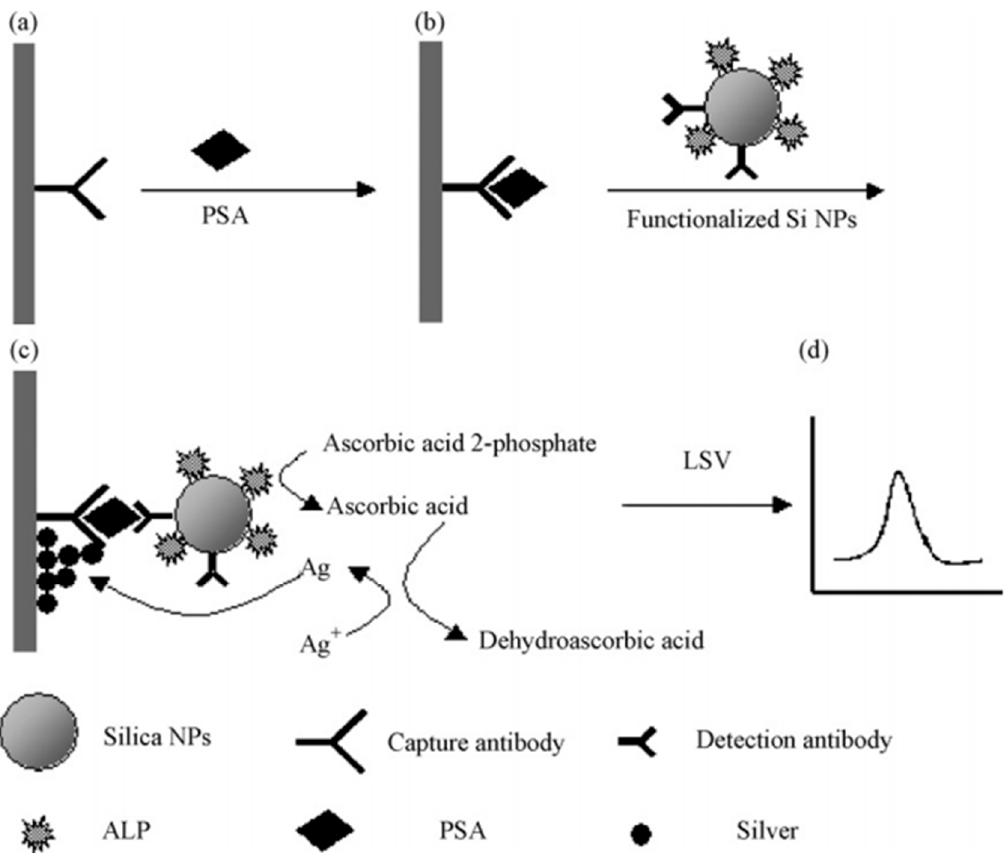
Figure 7. Schematic outline of the electrochemical immunosensor. ( a ) Immobilization of PSA capture antibody on the Au electrode; ( b ) capture of the analyte PSA in sample solution; ( c ) association with the functionalized silica NPs, reduction of silver ion by ascorbic acid and the deposition of metal silver on the electrode surface; ( d ) linear sweep voltammetry was used for the electrochemical detection of metal silver deposited on the electrode. Reprinted with permission from Talanta, 2008. 76(4): pp. 785–790. [107].